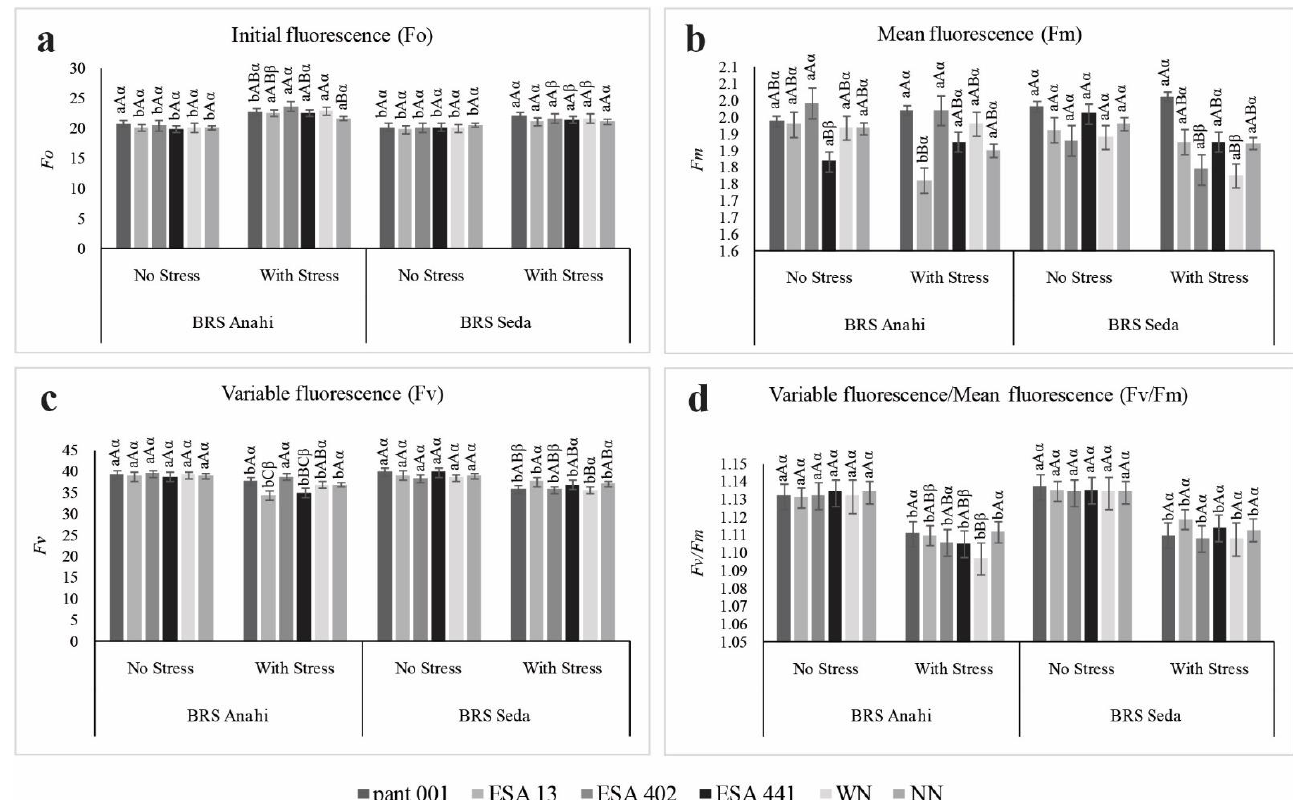
Figure 2. ( a ) Initial fluorescence (Fo), ( b ) average fluorescence (Fm), ( c ) variable fluorescence (Fv); ( d ) relationship between Fv/Fm, in sesame cultivars (BRS Anahí and BRS Seda) inoculated with bacilli, under water deficit and different nitrogen sources. WN-with nitrogen and NN-no nitrogen. Triple interactions: lowercase letters compare the water regime within each cultivar; capital letters compare treatments with inoculants within each cultivar; and Greek letters compare the cultivars.